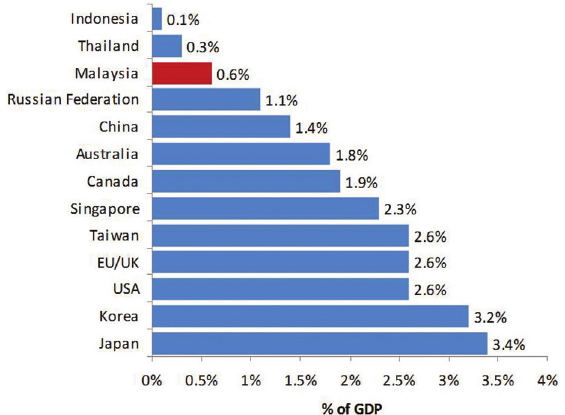
Figure 2 - Malaysia’s low R&D investment and GERD to GDP Expenditure by Country. Source: APEC Industrial Science & Technology Internationalization Database (2010), adopted from MSF